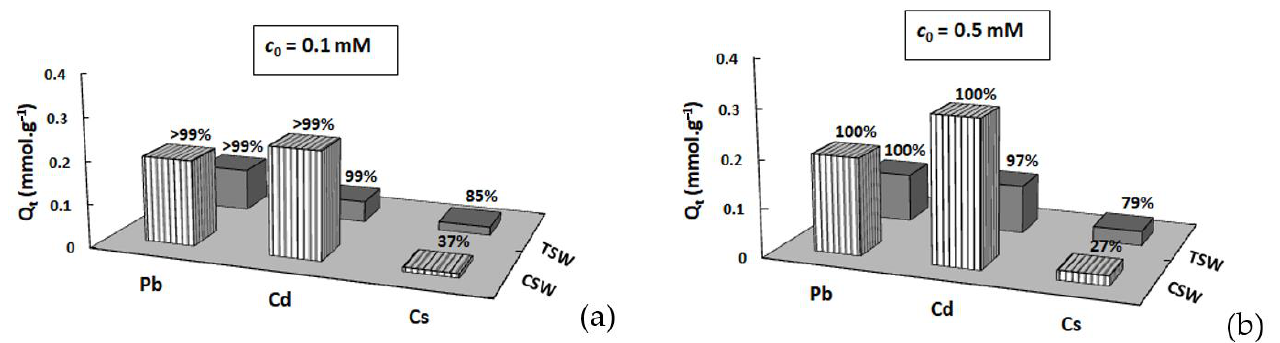
Figure 4. Theoretical adsorption capacities Q t of Pb 2+ , Cd 2+ and Cs + adsorption on CSW and TSW at initial concentration c 0 of 0.1 mmol·L −1 ( a ) and 0.5 mmol·L −1 ( b ). Percentages above the bars indicate the maximum adsorption efficiency.